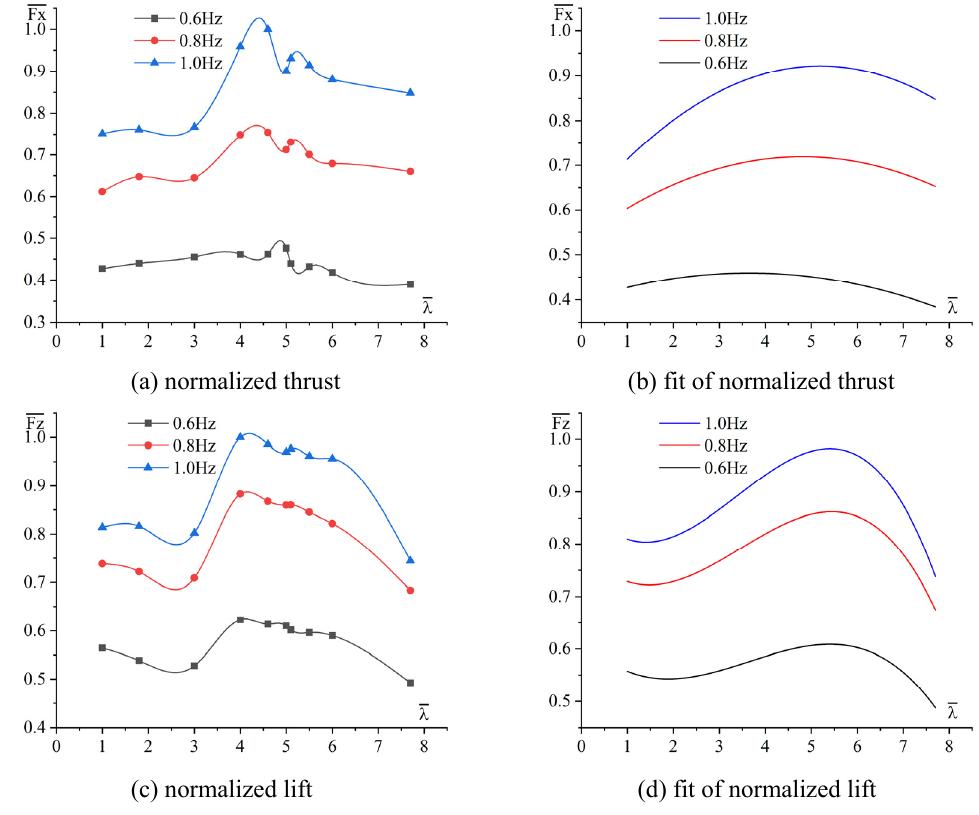
Figure 8. Polynomial fit of thrust/lift and relative flexibility.